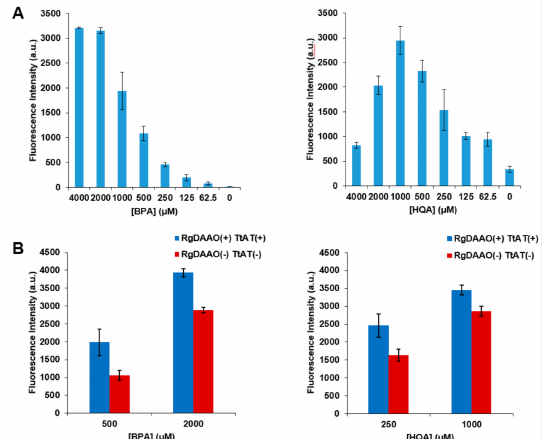
Figure 5. Genetic incorporation of BPA and HQA into EGFP. A GFP gene with an amber stop codon (TAG) at position 39 was expressed in the presence of the aminoacyl-tRNA (aa-tRNA) and aa-tRNA synthetase (aaRS) pair for BPA or HQA. ( A ) The expression was carried out with varied concentrations of racemic BPA or HQA, and GFP fluorescence was measured at 510 nm with excitation at 497 nm. ( B ) The expression was carried out with indicated concentrations of optically pure BPA or HQA prepared from the coupled enzymatic reactions, and GFP fluorescence was measured at 510 nm with excitation at 497 nm. Table 3. Fluorescence intensity of GFP-Y39TAG expressed by the GCE technique using optically pure BPA and HQA prepared by the coupled enzymes, RgDAAO and TtAT.